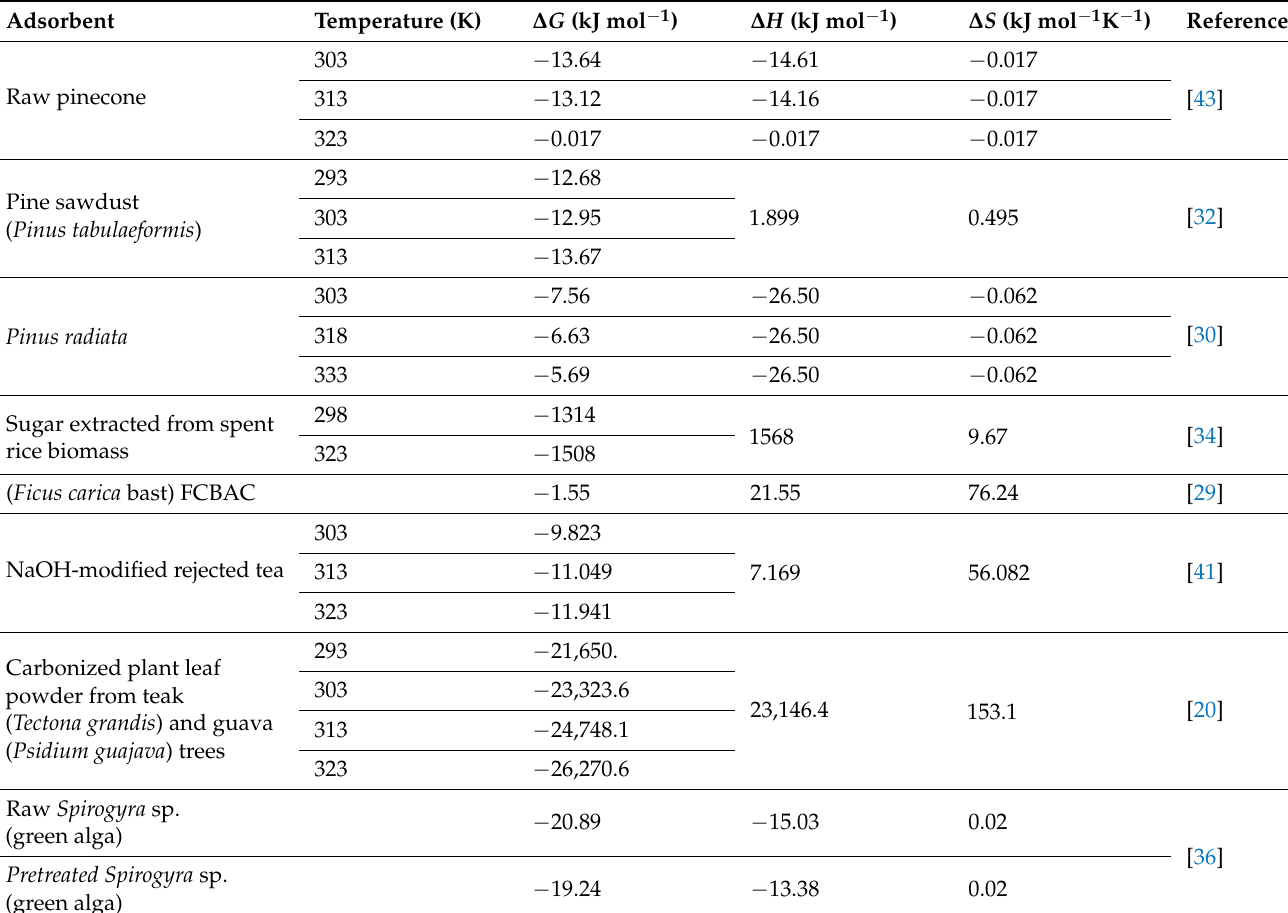
Figure 10. Effect of temperature on the adsorption of MB onto pinecone powder [30]. Table 3. Thermodynamic properties studied during MB